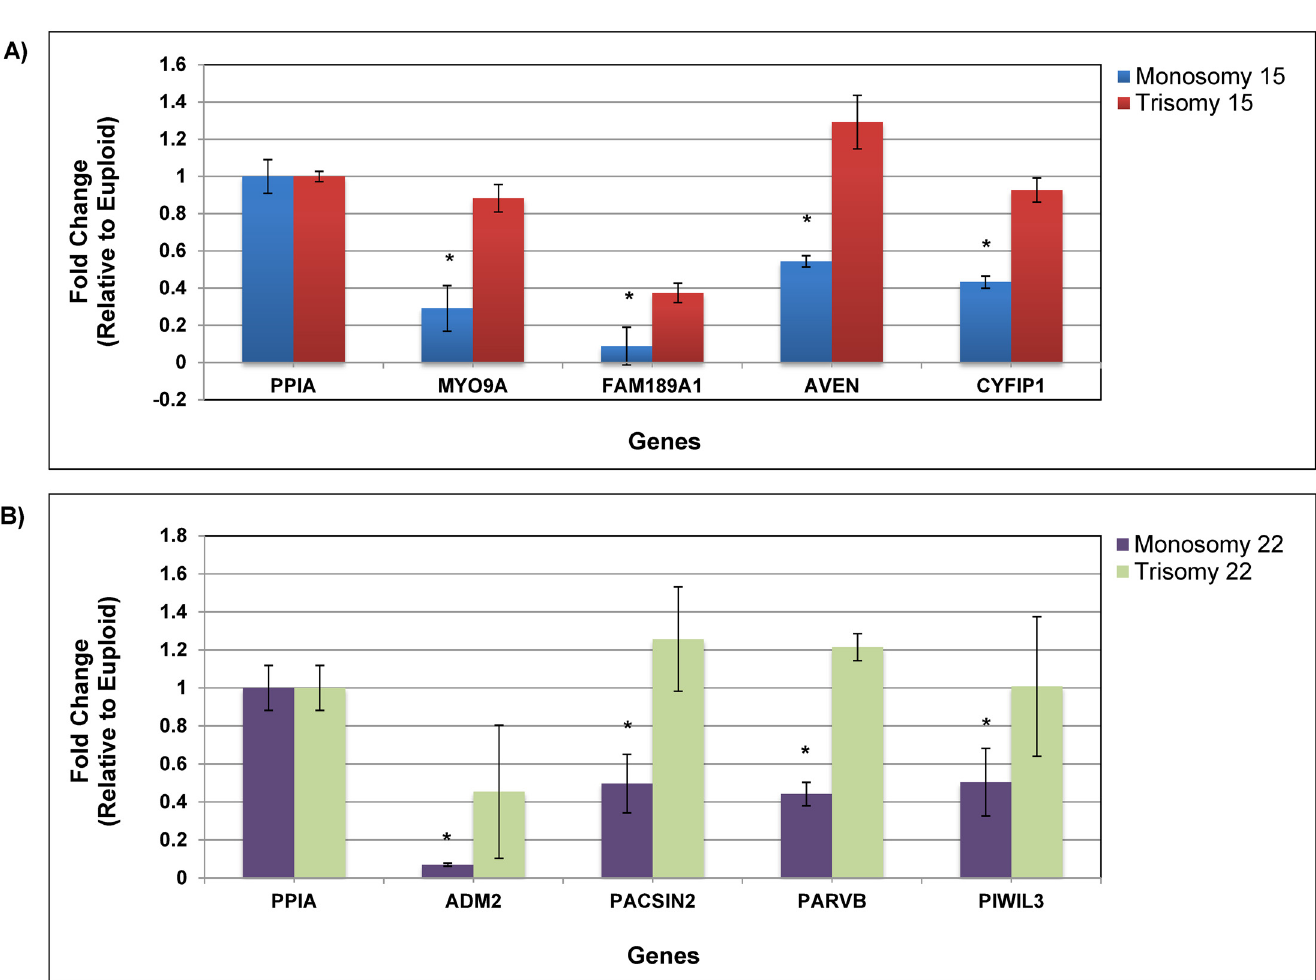
Fig 1. Developmental gene expression in individual human blastocysts (n = 10 replicates for each group) was performed by qPCR. Ct values were normalized to PPIA , an internal, constant housekeeping gene. Fold change was determined using the ΔΔ Ct method on the average of technical duplicates. Error bars represent standard error and the y-axis denotes fold change between euploid and aneuploidy. A) Signigicant decreased expression of chromosome 15 genes in monosomy 15 blastocysts compared to controls ( * P < 0.05). B) Significant decreased expression of chromosome 22 genes in monosomy 22 blastocysts compared to controls ( * P <